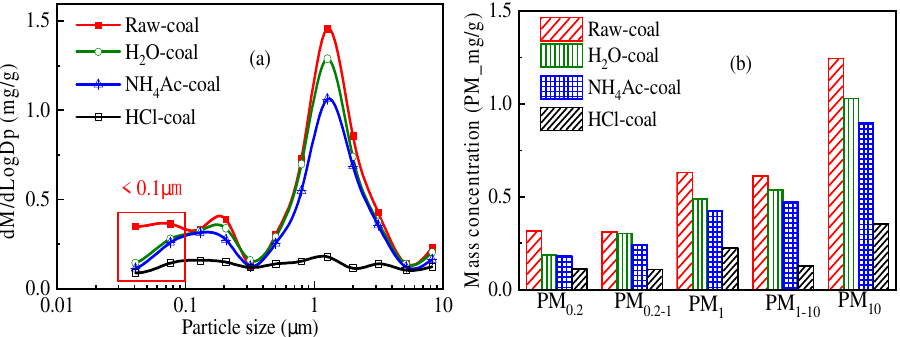
Figure 8. Continuous ( a ) and discrete ( b ) distribution of PM10 at different processing methods.